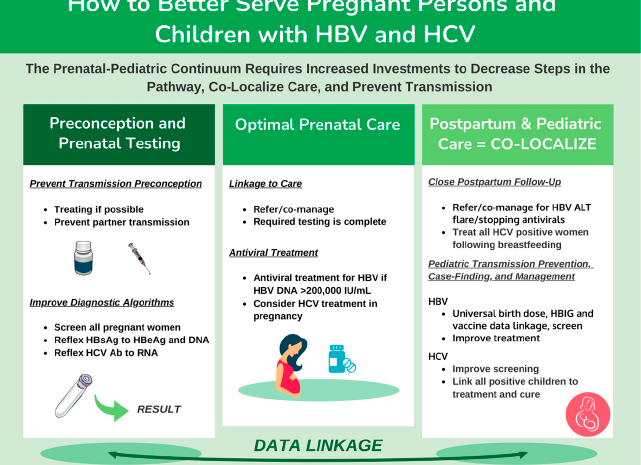
Figure 3. Opportunities towards the elimination of HBV and HCV in pregnant persons and children.